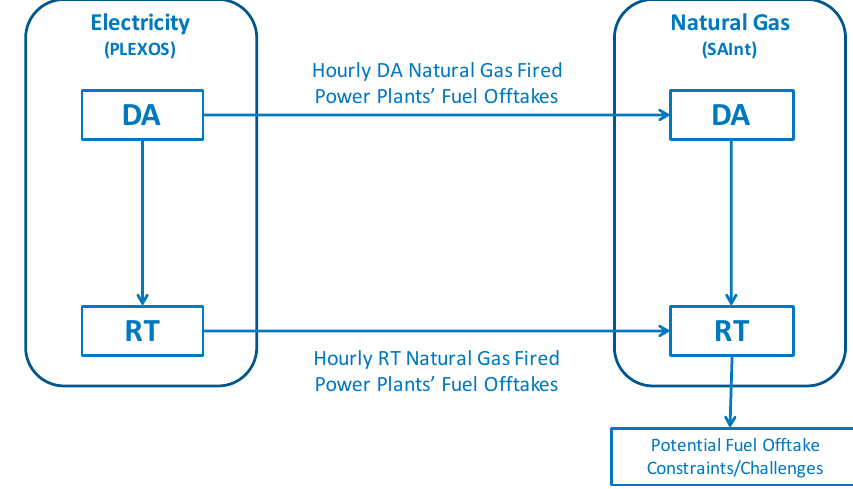
Figure 5. Simulation Model for Business As